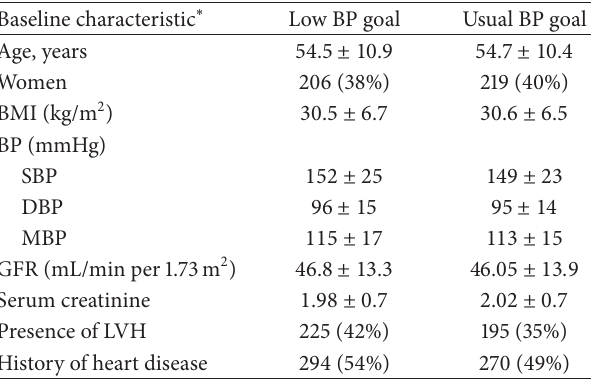
Table 1: Baseline and clinical characteristics of study participants ( 𝑁 = 1094 ) mean SD or frequency (%).